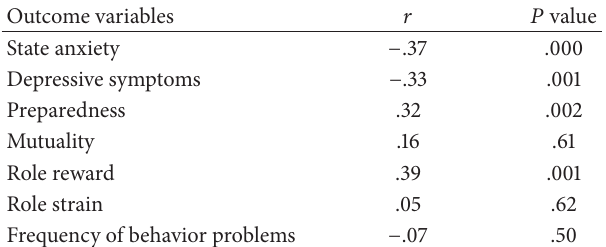
Table 1: Demographic and clinical baseline variables by group.